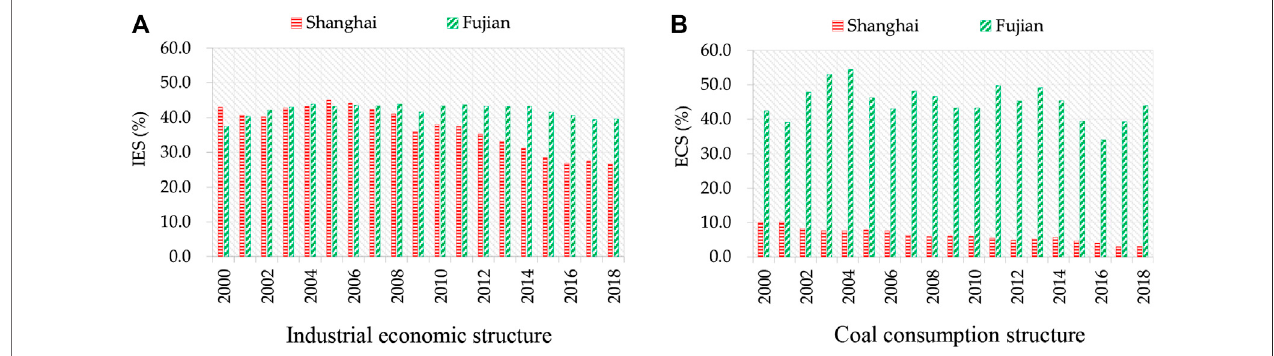
FIGURE 2 | Comparison of IES and ECS between Shanghai and Fujian Province. (A) Industrial economic structure. (B) Coal consumption